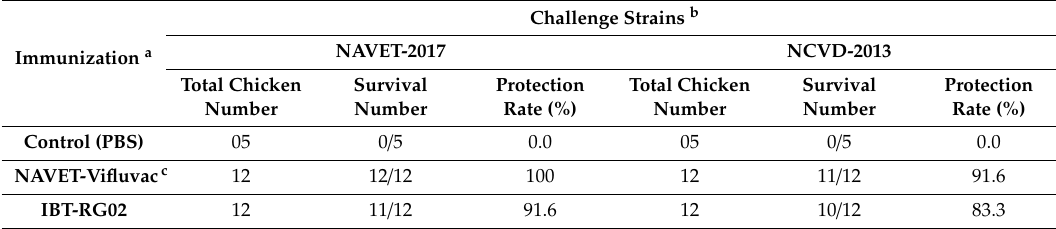
Table 3. Protection of 3-week-old chickens against HPAI challenge after immunization with IBT-RG02.